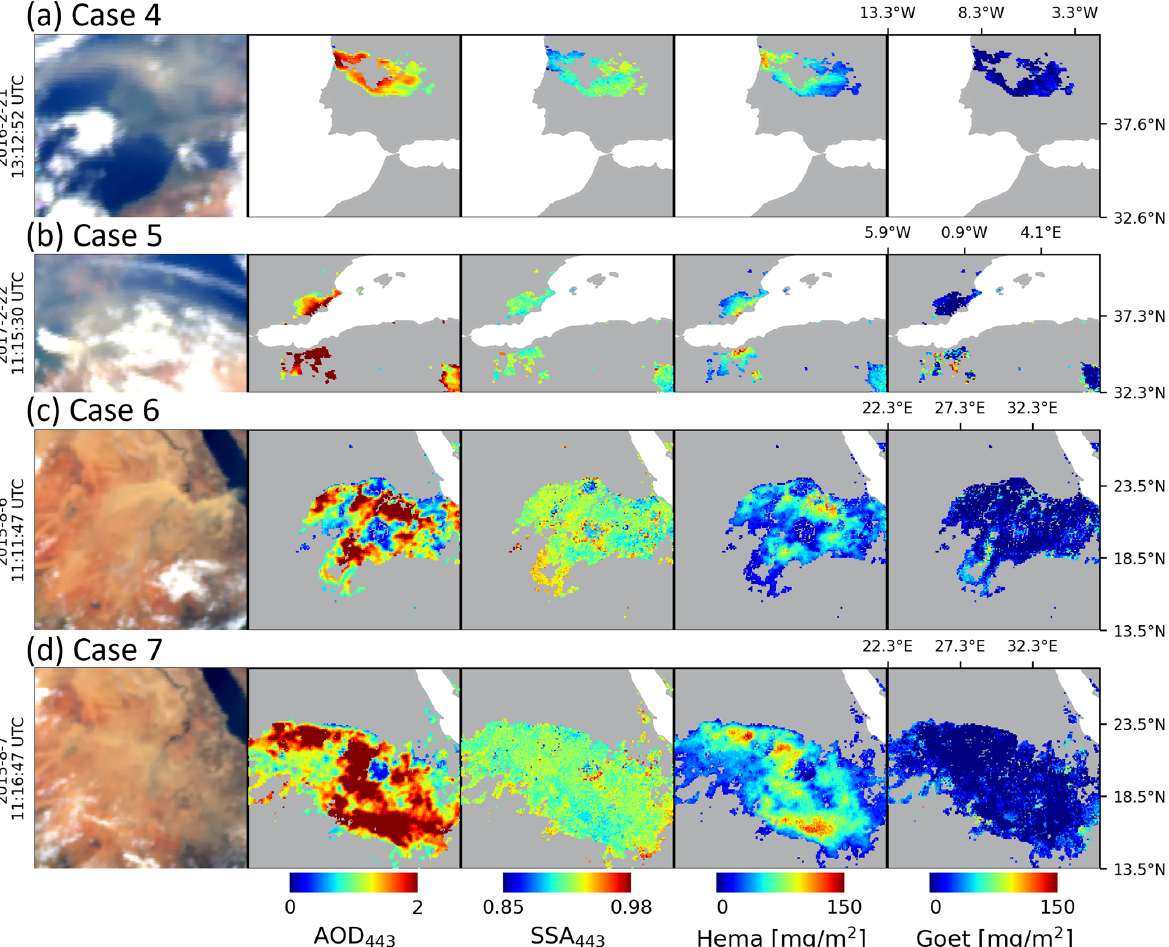
Figure A1. Dust episodes over the northern Sahara (rows 1 and 2) and near the Red Sea (rows 3 and 4). From left, RGB TOA image generated from EPIC L1B version 3 data, AOD and SSA at 443nm, and mass concentration of hematite and goethite for each case: case 4 (row 1), dust episode on 21 February 2016; case 5 (row 2), dust episode on 22 February 2017; case 6 (row 3), dust episodes on 6 August 2015; and case 7 (row 4), dust episodes on 7 August